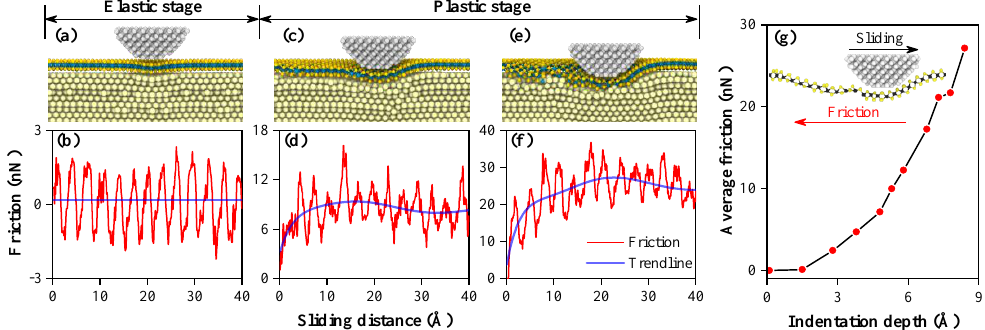
Figure 6. Cutaway view of the model and the friction-distance curves during the sliding process, ( a , b ) indentation depth = 1.5 Å at elastic stage; ( c , d ) indentation depth = 5.4 Å, at plastic stage; ( e , f ) indentation depth = 8.4 Å at the critical loading depth. ( g ) Average friction varies with the indentation depths during the sliding process.